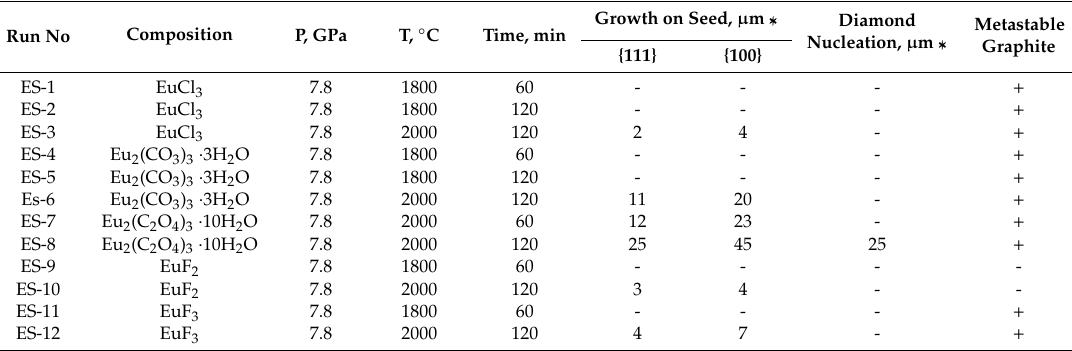
Table 1. Experimental conditions and